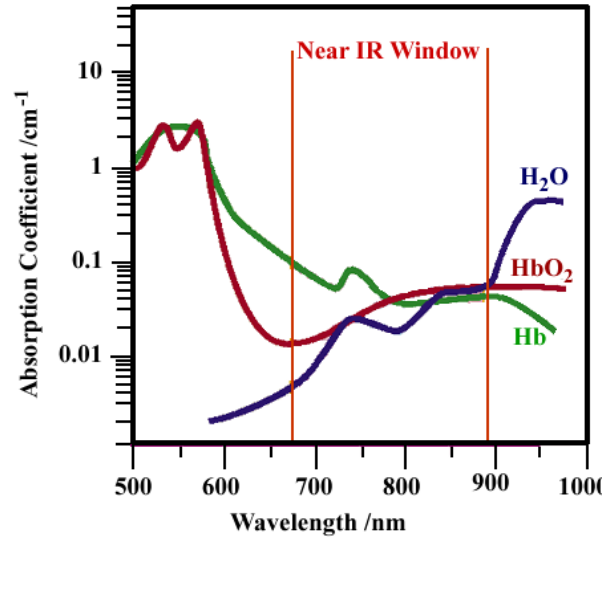
Figure 22. Absorption versus wavelength for hemoglobin and water showing the near infrared (NIR) window for in vivo imaging to minimize absorption and scattering